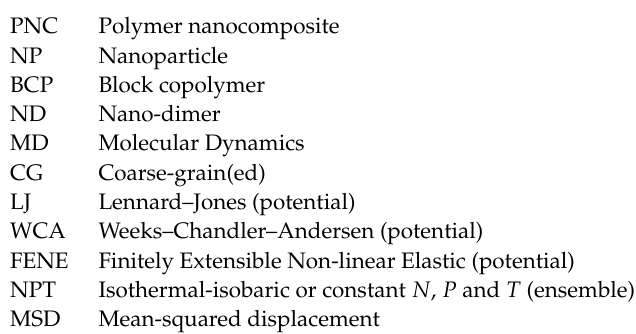
Figure S3: Density profiles, Figure S4: Polar, absolute polar, and azimuthal average angle values as a function of the z coordinate, Figure S5: Mean squared displacement of chain monomers and chains’ centre of mass at each system, Figure S6: Mean squared displacement of NDs at each system, Figure S7: Accumulated time autocorrelation functions and convergence behaviour of D Rot as a function of